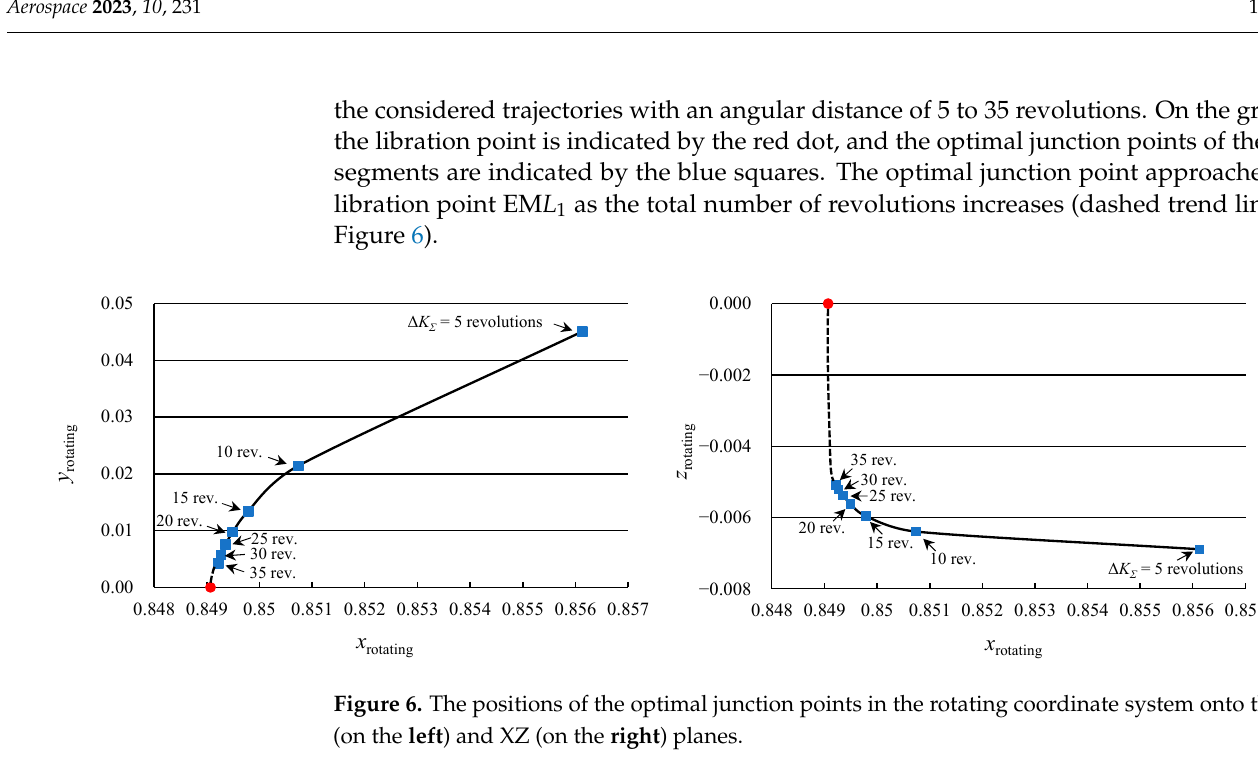
Figure 5. The time dependences of the velocity in the rotating coordinate system on the 5-(on the left), 20-(in the middle), and 35-revolution (on the right) trajectories with an optimal junction point and with an intermediate EML 1 rendezvous.